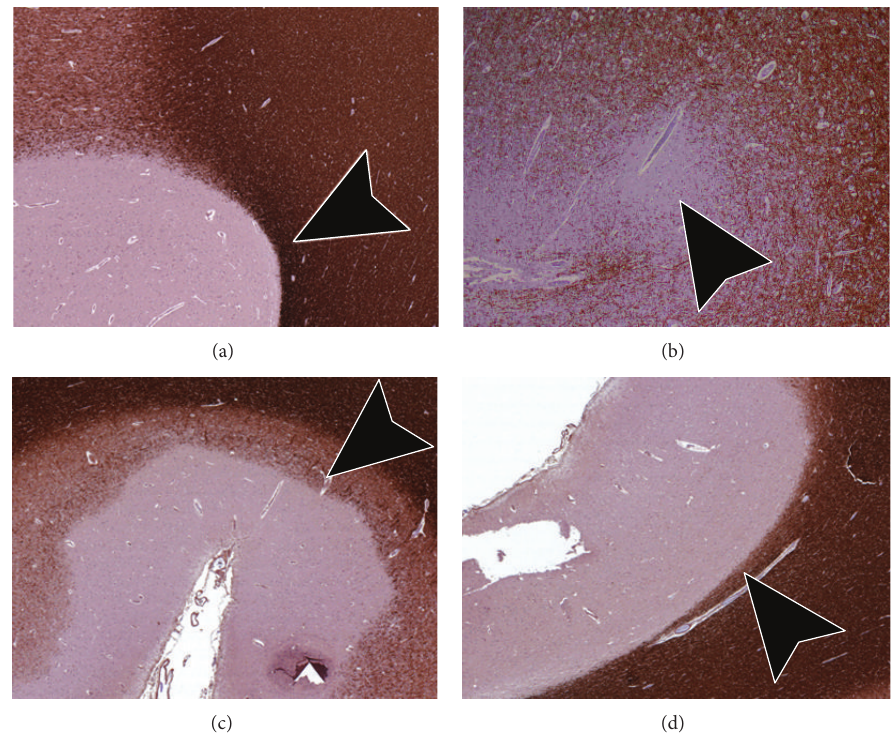
Figure 1: Pathologic classification of cortical lesions. (a) Type1 “Leukocortical” lesions involve thedeeper layers of gray matter and underlying white matter. Arrow head demonstrates the portion of the lesion extending into the white matter. (b) Type 2 “Intracortical” lesions are small lesions completely contained within the cortex, typically centered around small blood vessels. (c) Type 3 “Subpial” lesions extend from the pial surface into the superficial cortical layers, not reaching the white matter. (d) Type 4 “Subpial” lesions involve all layers of the gray matter but do not involve underlying white